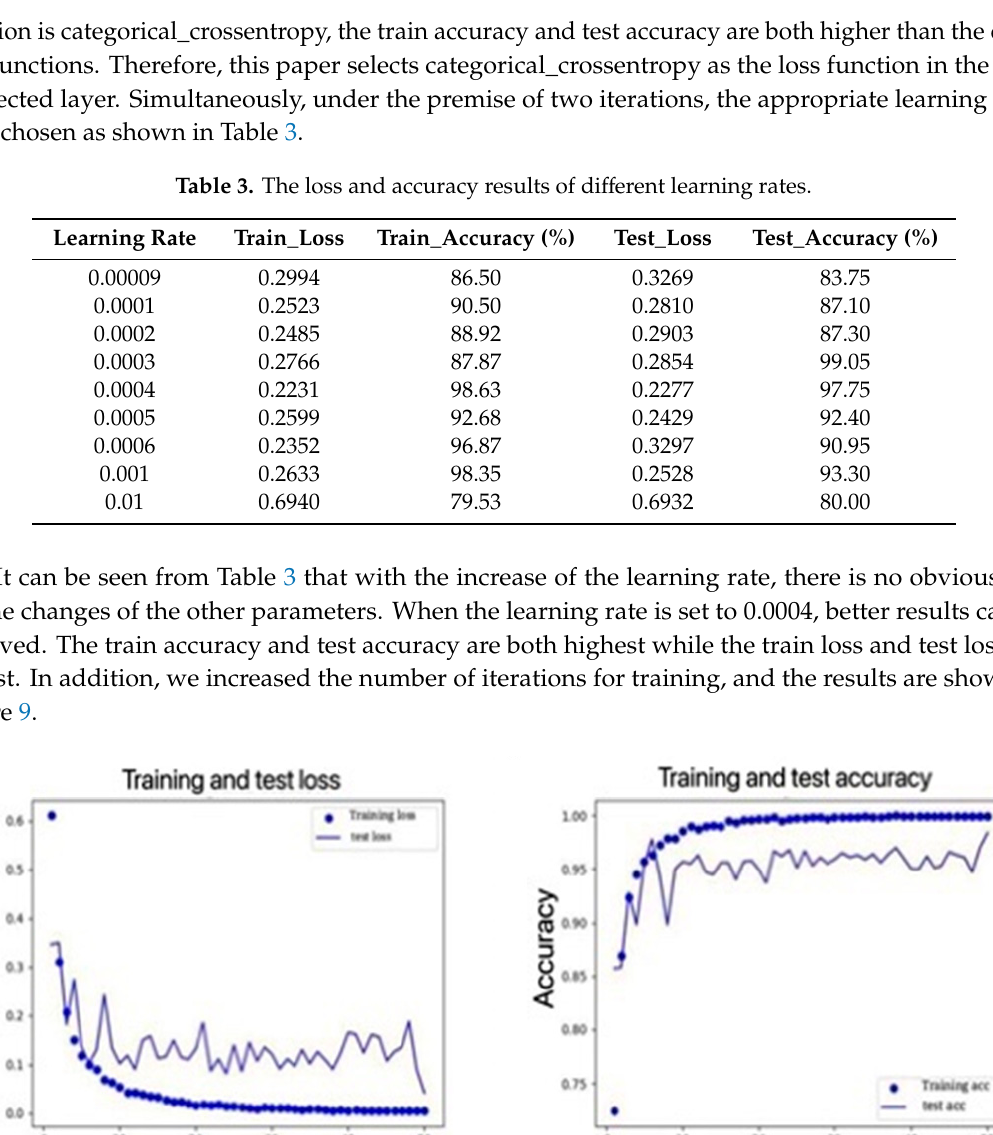
Figure 9. ( a ) The training and test loss of different iterations and ( b ) the training and test accuracy of different